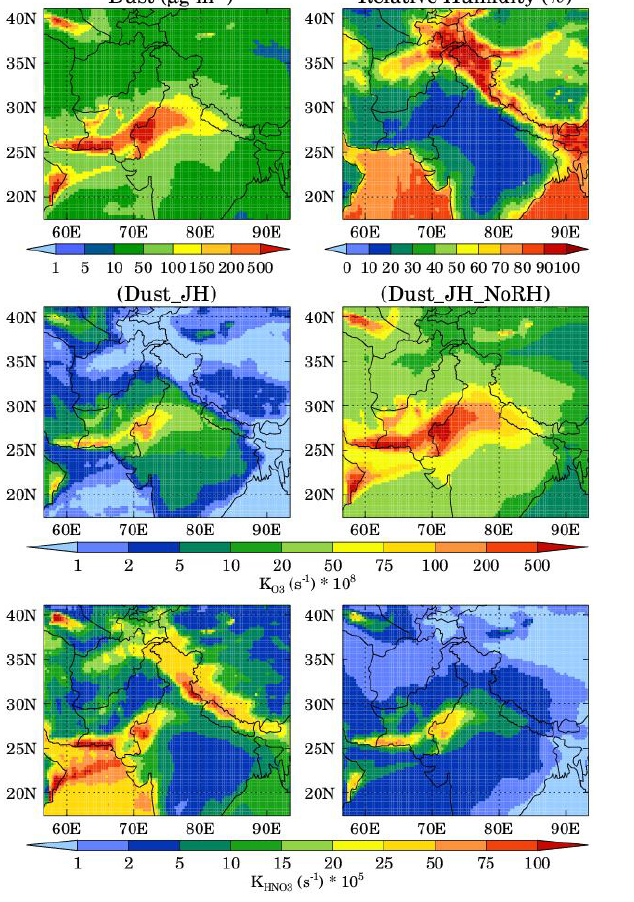
Figure 8. Spatial distributions of average mass concentration for dust particles of 1.4µm effective radius, relative humidity and pseudo-first-order rate coefficients for heterogeneous uptake of ) and HNO 3 ( k HNO ) by dust particles in Dust_JH and O 3 ( k O 3 3 Dust_JH_NoRH configurations during 17–22 April